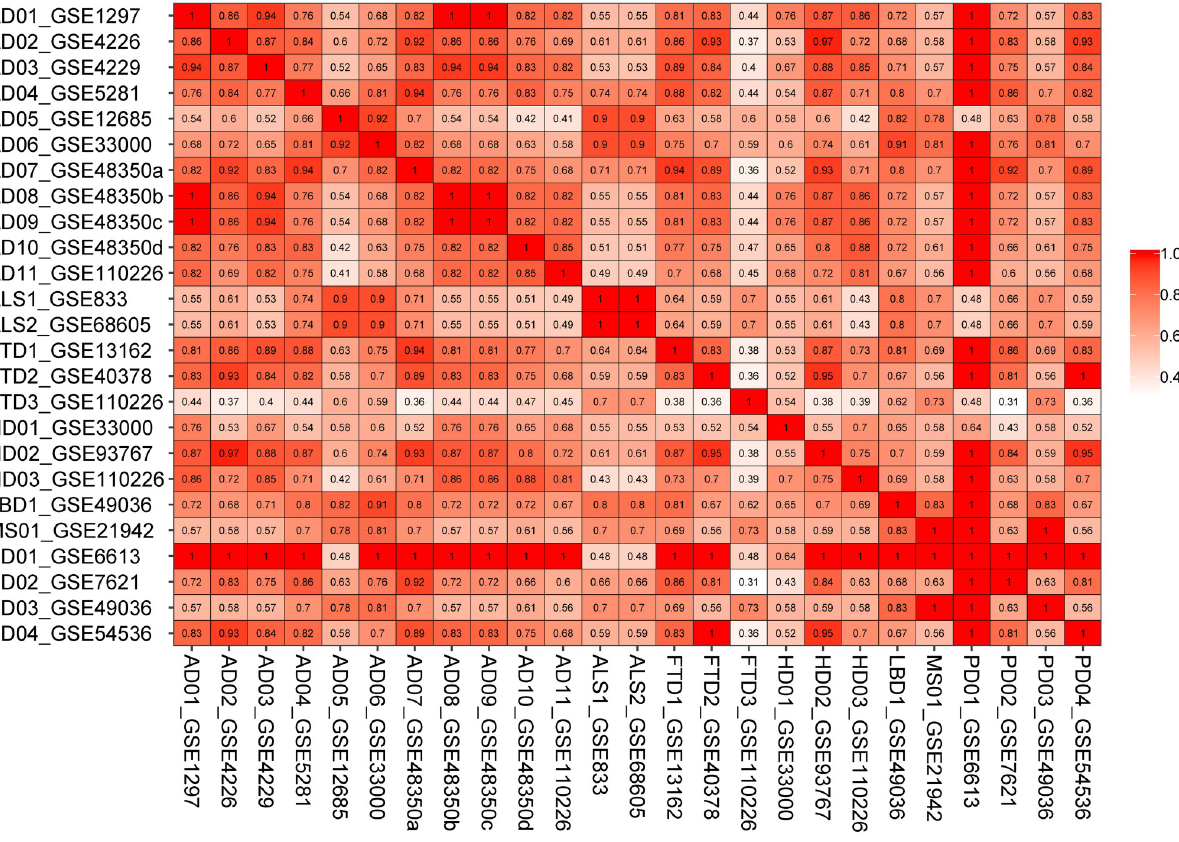
Fig 5. Semantic similarity matrix for the five most significant GO terms. Entry names are similar as Fig